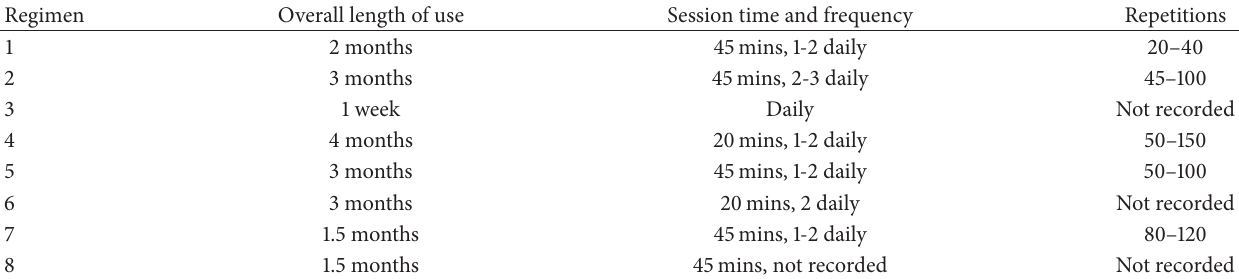
Table 1: SaeboFlex